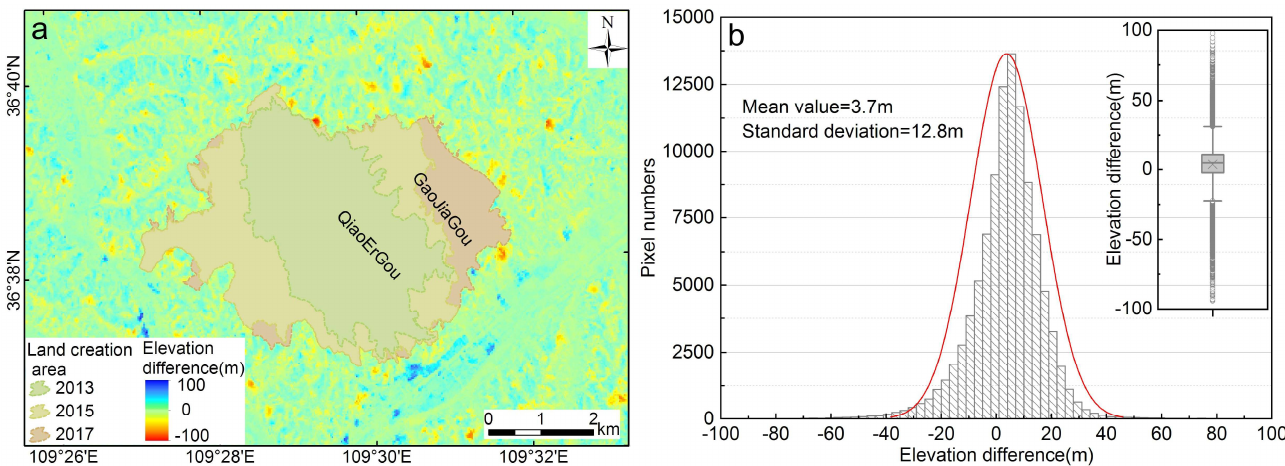
Figure 5. Elevation difference in non-YND areas between the SRTM and ZY-3 DEMs from 2000 to 2017; ( b ) the corresponding histogram of ( a ).